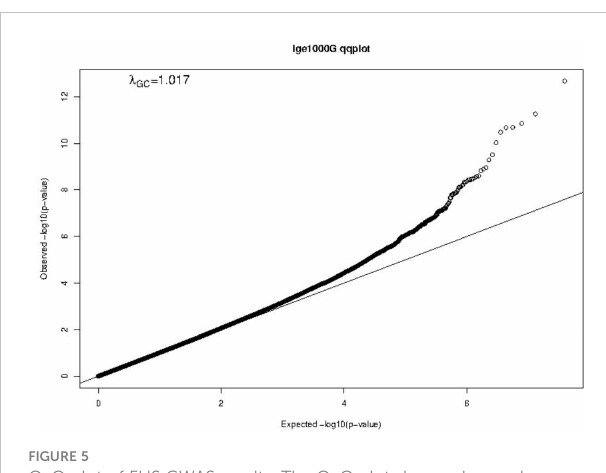
FIGURE 5 Q-Q plot of FHS GWAS results. The Q-Q plot shows observed vs. expected − log10(P-values) of the GWAS results. The straight line represents the SNP distribution under the null hypothesis.